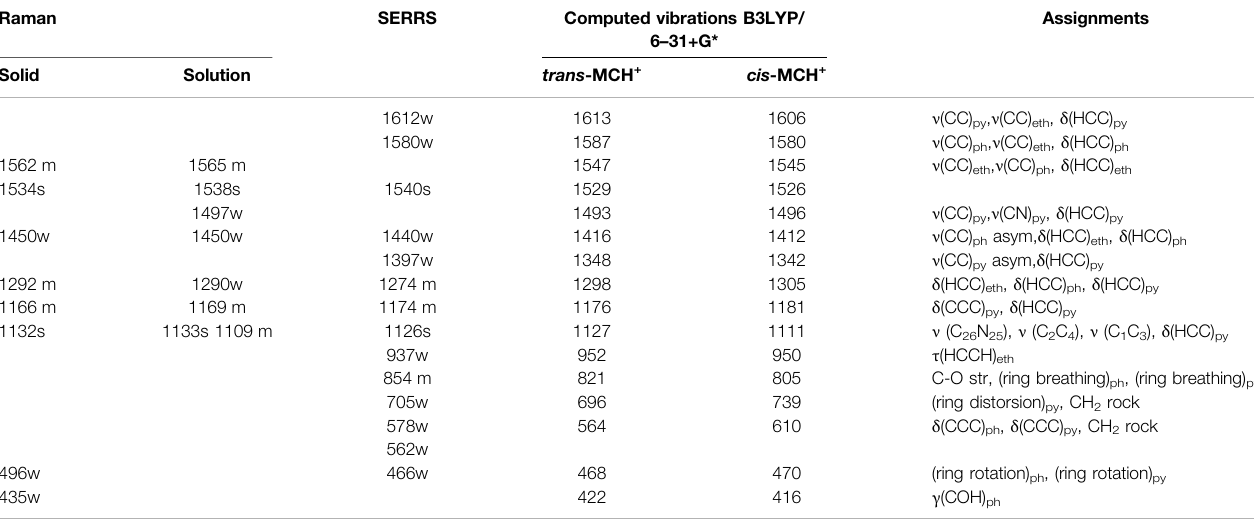
TABLE 1 | Assignments of Raman spectrum in solid, acetonitrile and SERRS spectrum of merocyanine along with the B3LYP/6 – 31+G* computed vibrations (in cm − 1 ) of MCH + . Raman SERRS Computed vibrations B3LYP/